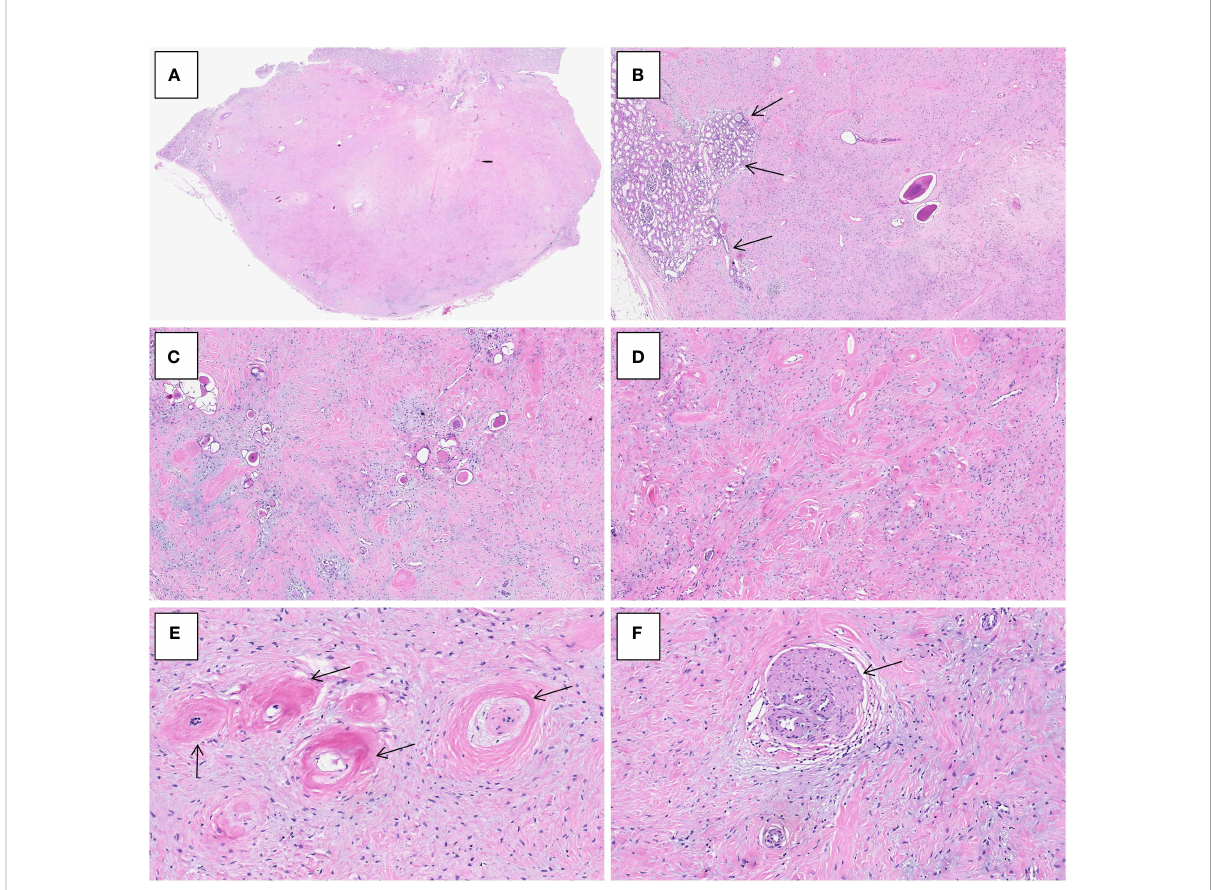
FIGURE 2 Histological characteristics of adult metanephric stromal tumor with BRAF V600E mutation. (A) At low power, the tumor is non-encapsulated and has an overall expansile contour. H&E×15. (B) Subtly in fi ltrative border of the tumor with adjacent normal renal parenchyma (arrows). H&E×40. (C) Numerous entrapped native renal tubules are noted. H&E×100. (D) The tumor is composed of bland, spindle- or stellate-shaped cells, set in a predominantly collagenous and focally myxoid stroma. H&E×100. (E) The highly hyalinized stroma encircles and entraps native renal tubules (arrows). H&E×300. (F) The tumor induces angiodysplasia within entrapped blood vessels (arrow).